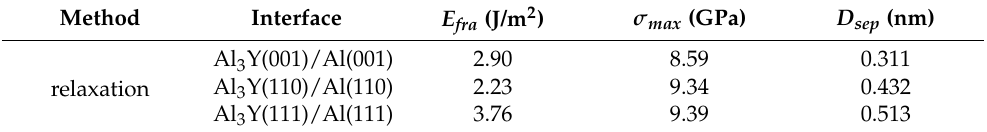
Table 6. Separation distance ( D sep ), maximum separation energy ( E fra ), and maximum tensile stress ( σ max ) of the interfaces.